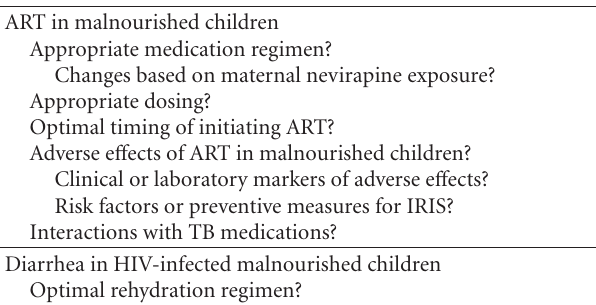
Table 2: Selected examples of open research questions in the care of HIV-infected children with severe